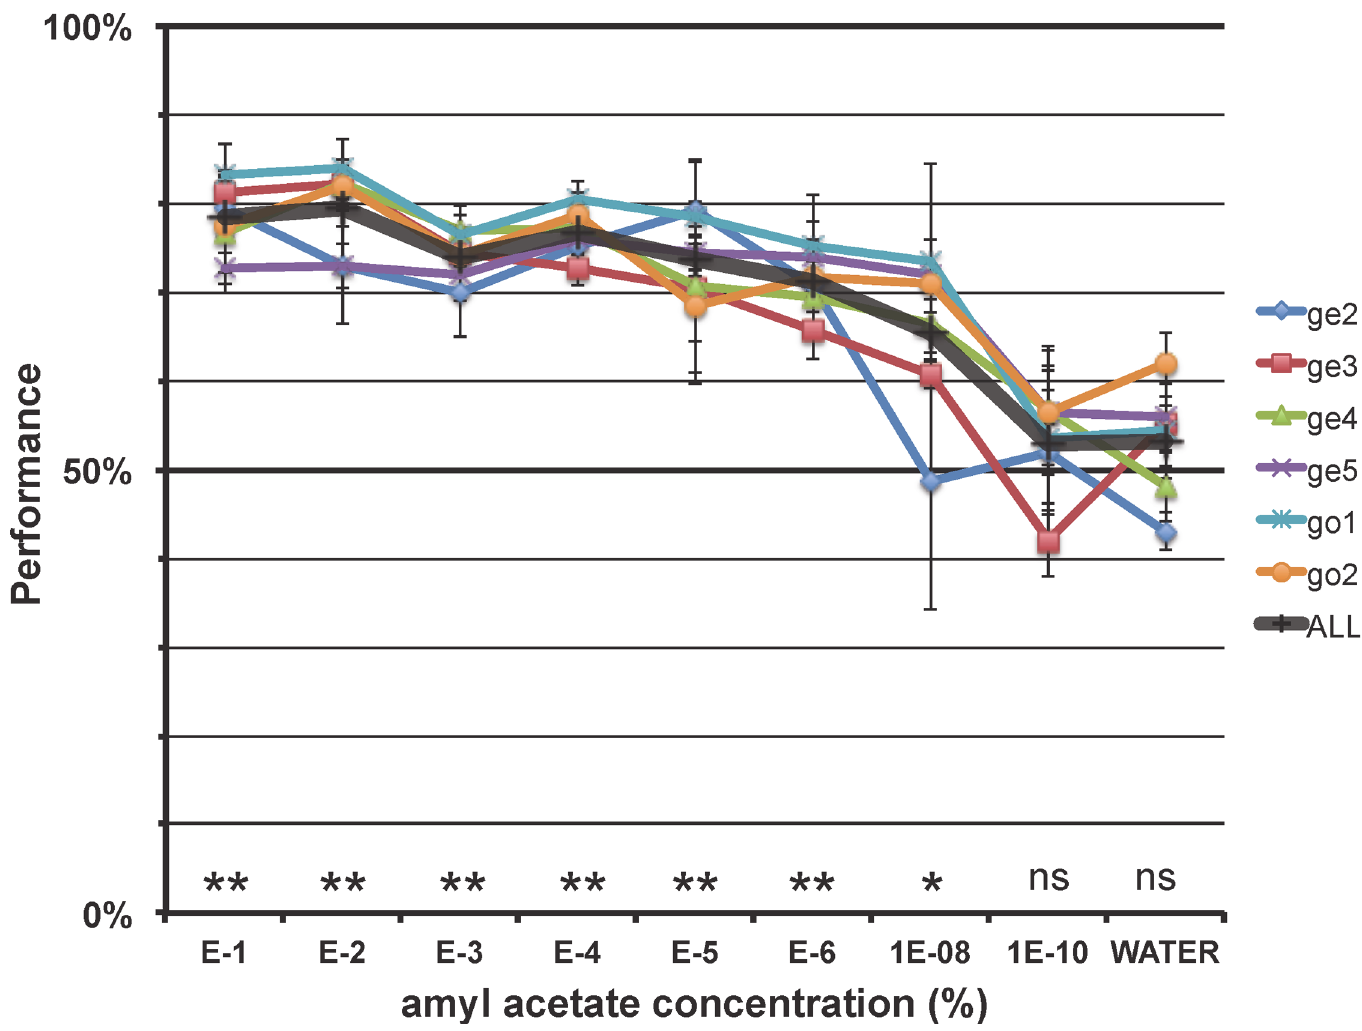
Fig 2. Retronasal odor discrimination performance of mice. Graph showing average ( ± SEM) and individual performance accuracy of 6 mice discriminating between a range of concentrations of licked retronasal amyl acetate (AA) and water. ** p < 10 -7 , * p < 0.0002, ns not significant (unpaired t-test for performance > 50%). Mouse labels: ge: GCaMP3-EMX; go: